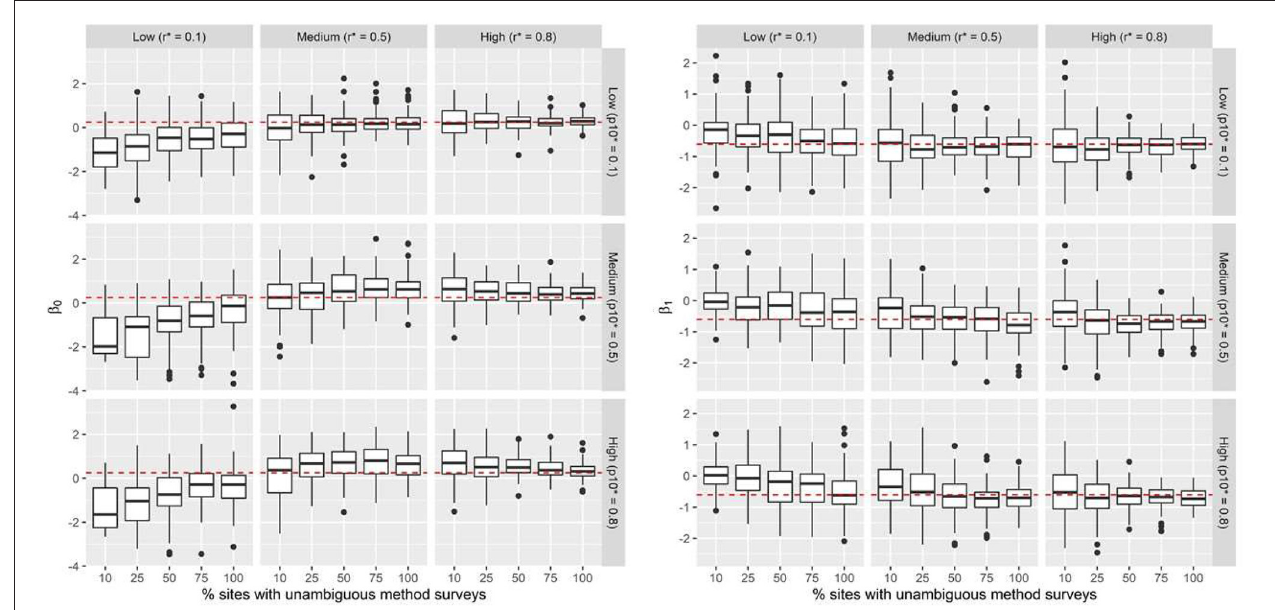
FIGURE 1 | Simulation results: Boxplots summarize predicted posterior mean probabilities for β 0 and β 1 across 45 scenarios. Data were simulated across a range of false-positive conflict reporting probabilities ( p 10 *), true detection probabilities for the unambiguous method r * , and percentage of sites where the unambiguous method is applied. The dashed red line indicates the true value of the intercept ( β 0 = 0.25) and slope ( β 1 = − 0.6) parameters. Black dots represent outliers.